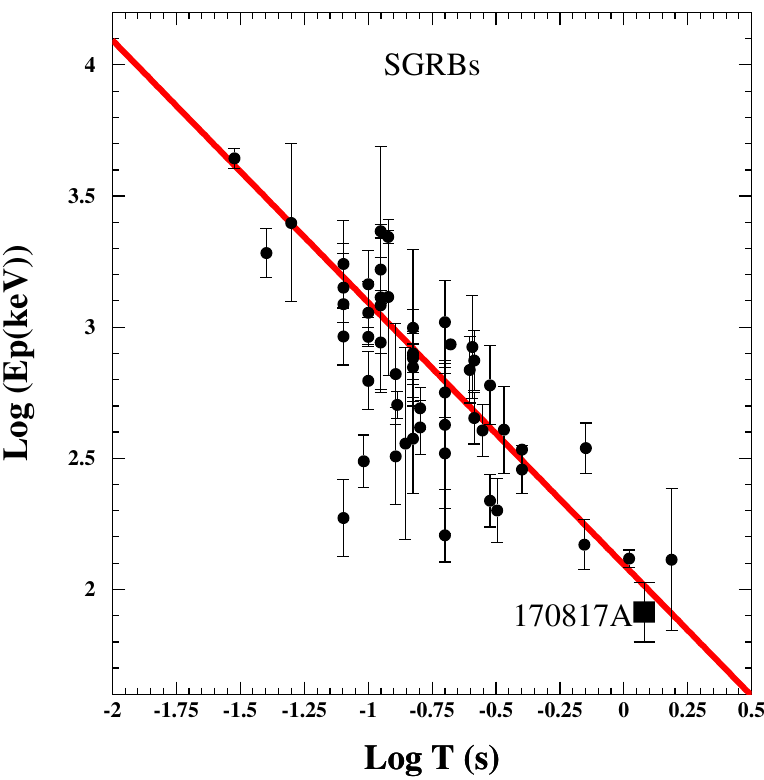
Figure 33. Comparison between the predicted [ E p , T p ] correlation of Equation (29) and the corre- sponding data in GCN circulars for 54 resolved pulses of SGRBs, obtained by the Konus-Wind and Fermi-GBM